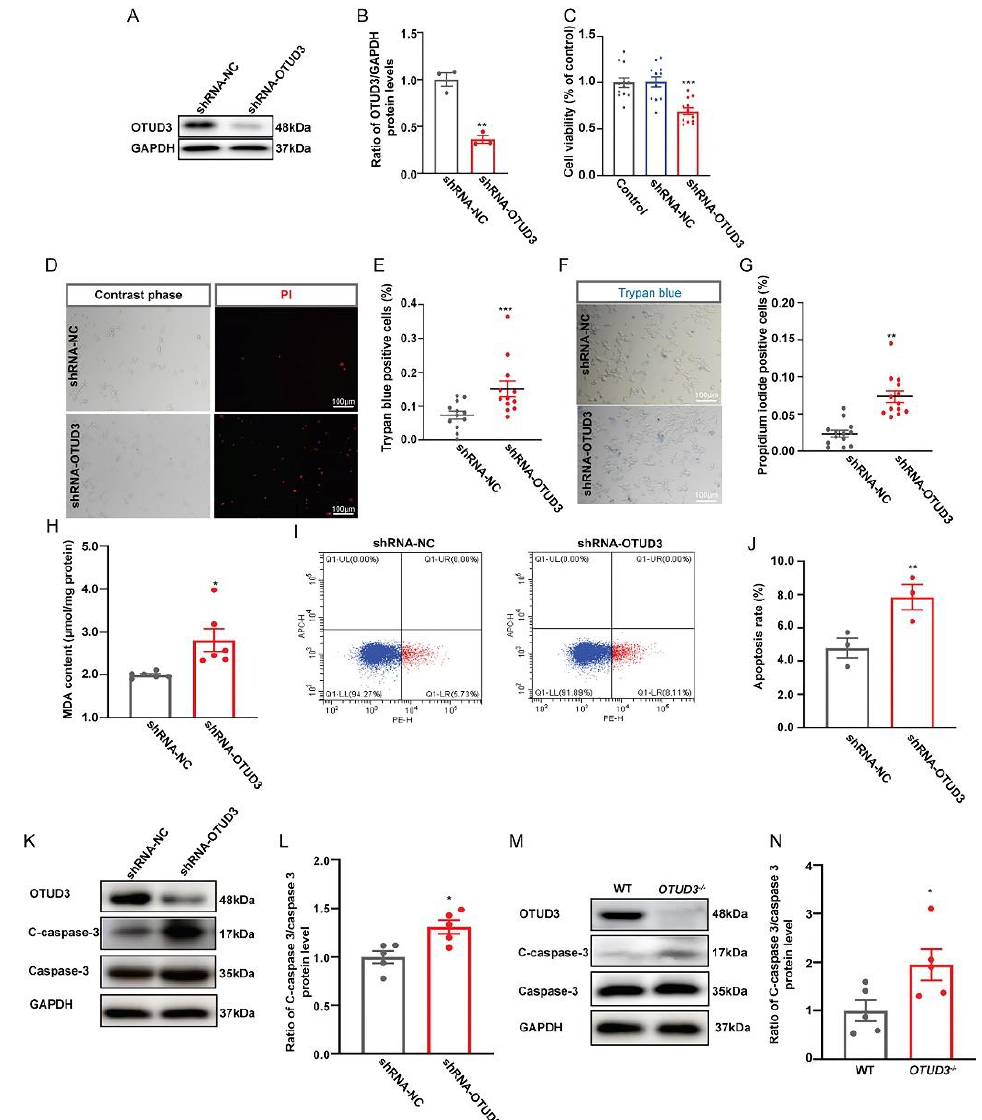
SN of OTUD3 − / − mice (Figure 1K–N). These data indicated that knockdown of OTUD3 partially induced dopaminergic neurons deaths through apoptosis.